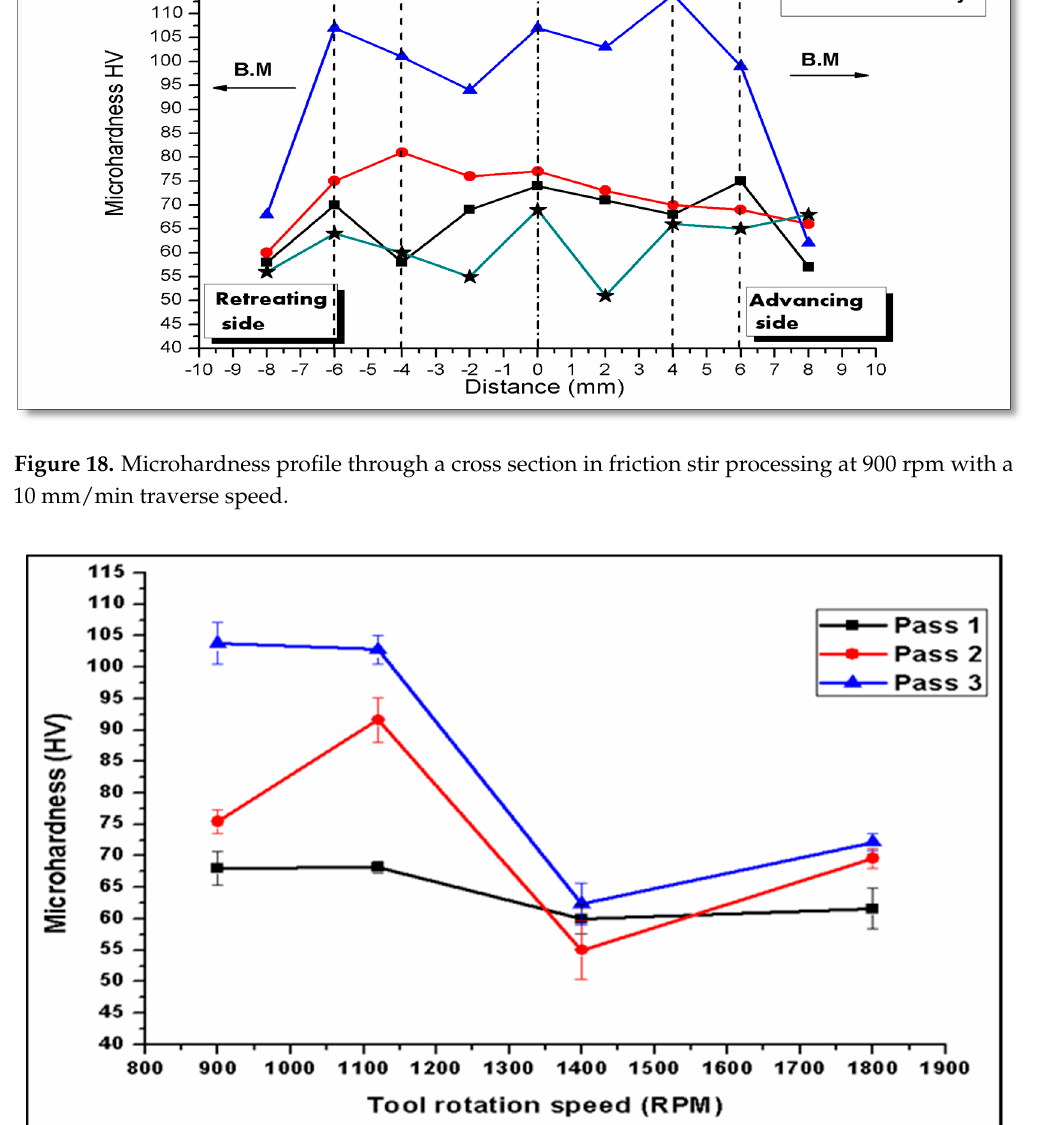
Figure 18. Microhardness profile through a cross section in friction stir processing at 900 rpm with a 10 mm/min traverse speed.